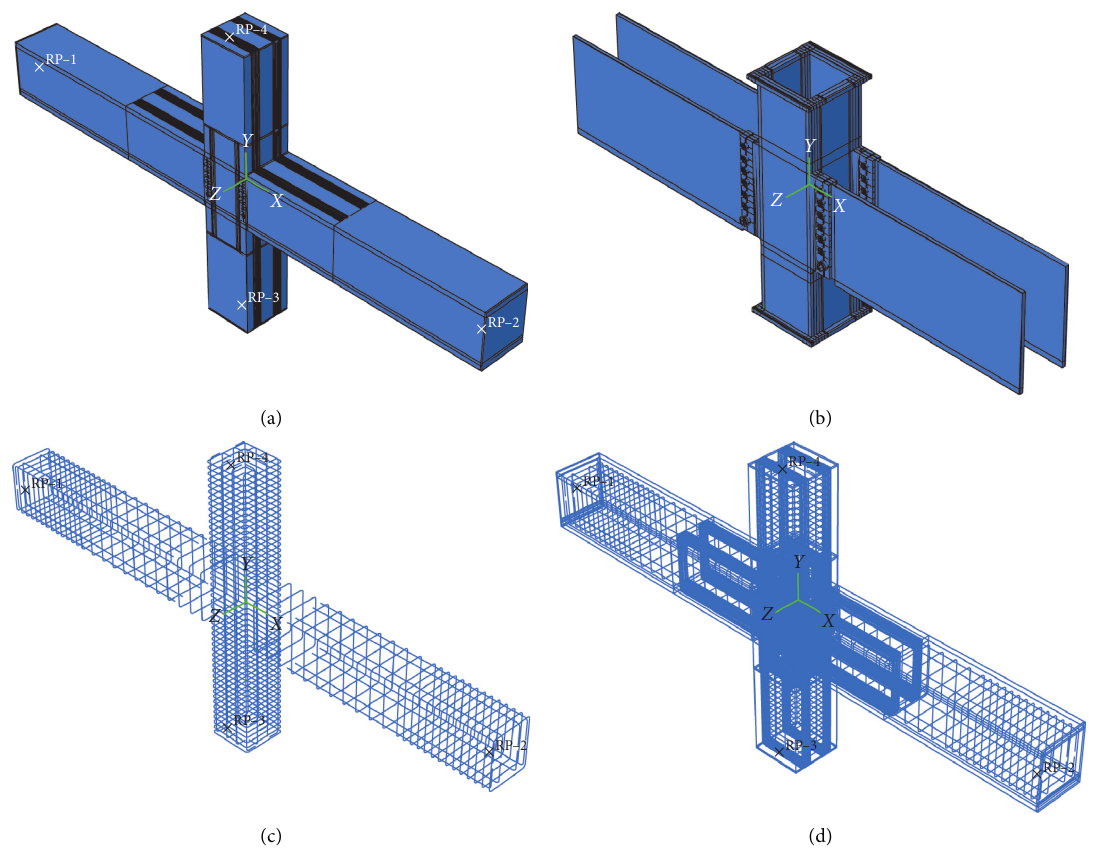
Figure 19: Finite element modeling (embedded components). (a) Concrete part. (b) Steel plate part. (c) Reinforcement part. (d) Total modeling.